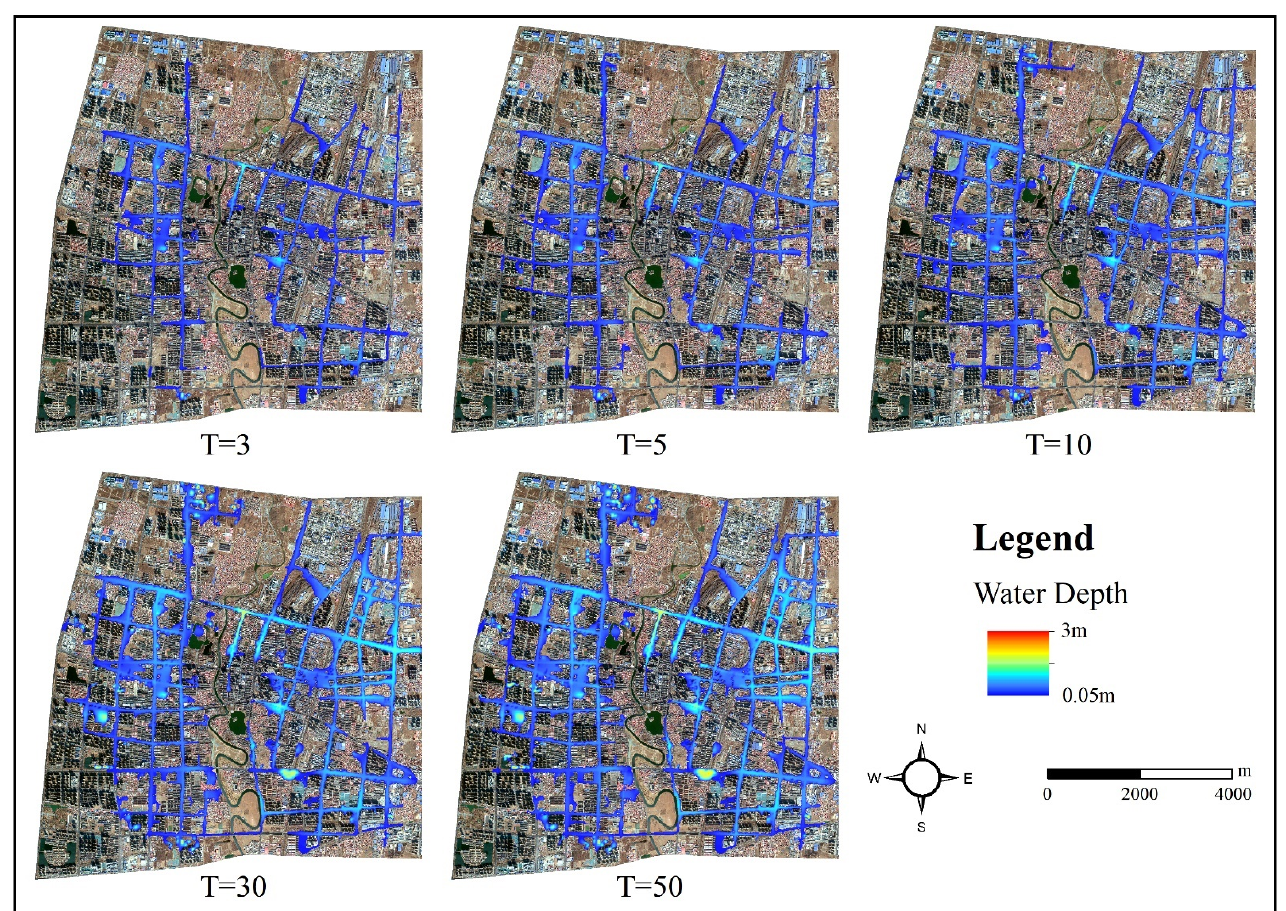
Figure 6. Spatial distribution of the maximum inundation depth under different return periods. Remote Sens. 2021 , 13 , x FOR PEER REVIEW 12 of 19